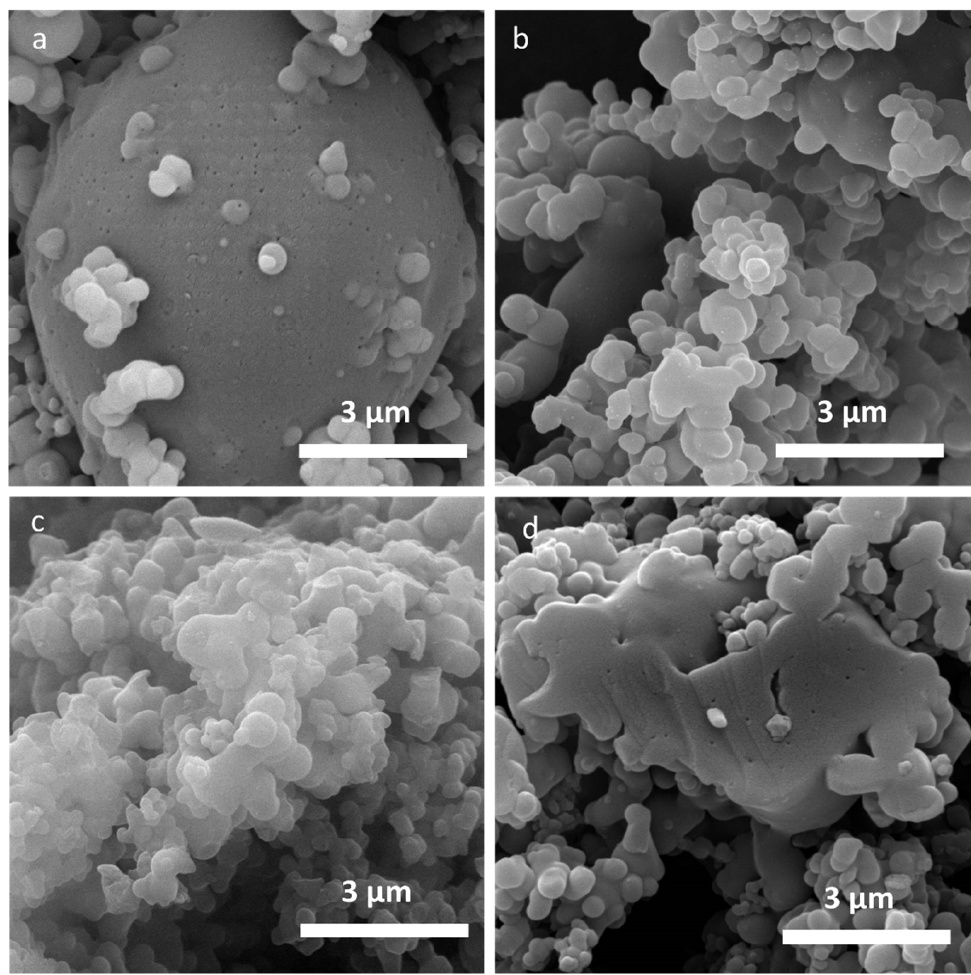
Figure 1. SEM micrographs of organosolv lignin samples, ( a ) O 250 ; ( b ) O 800 ; ( c ) O 1600 ; ( d ) O 2000 .